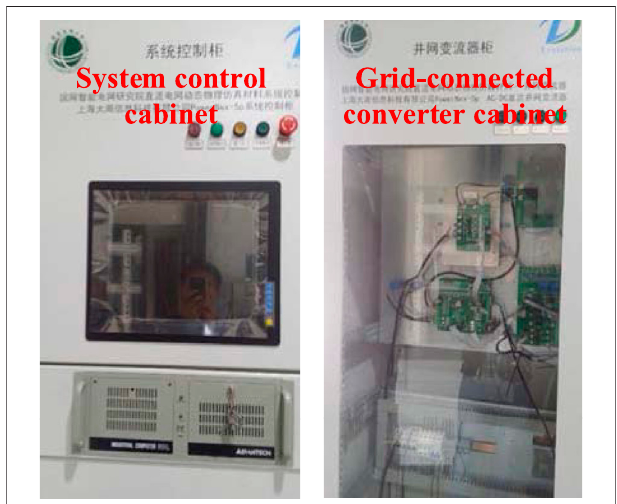
FIGURE 9 | Partial components display of the DC microgrid prototype.